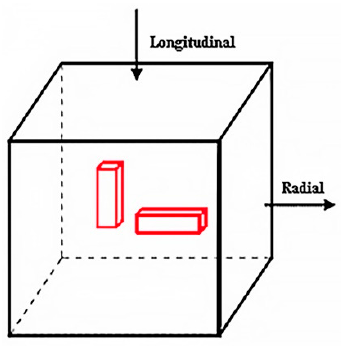
Figure 1. Schematic diagram of sample sampling.